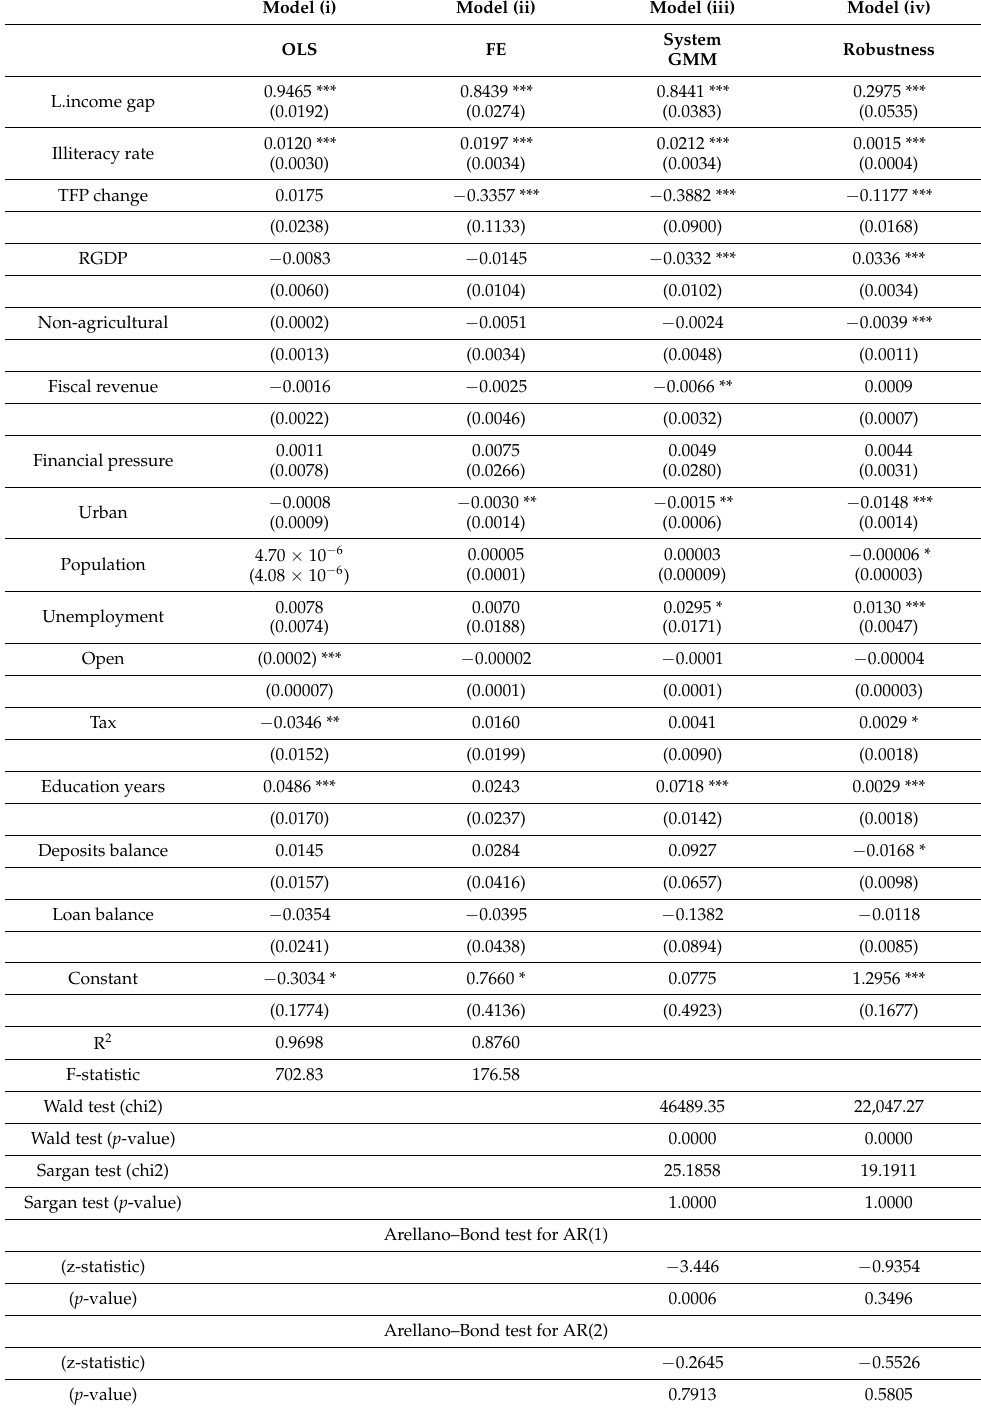
Table 5. The influence of the TFP and the education level of farmers on the rural–urban income